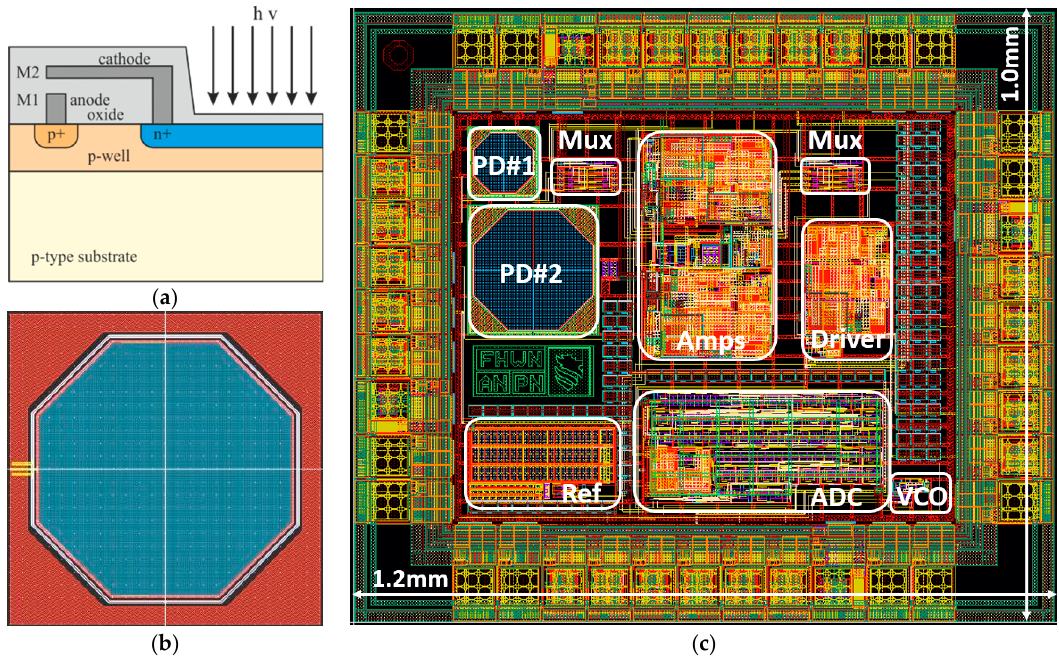
Figure 2. Universal Integrated Photodetector Platform: ( a ) photodiode cross section, ( b ) photodiode layout and ( c ) complete chip layout with highlighted functional